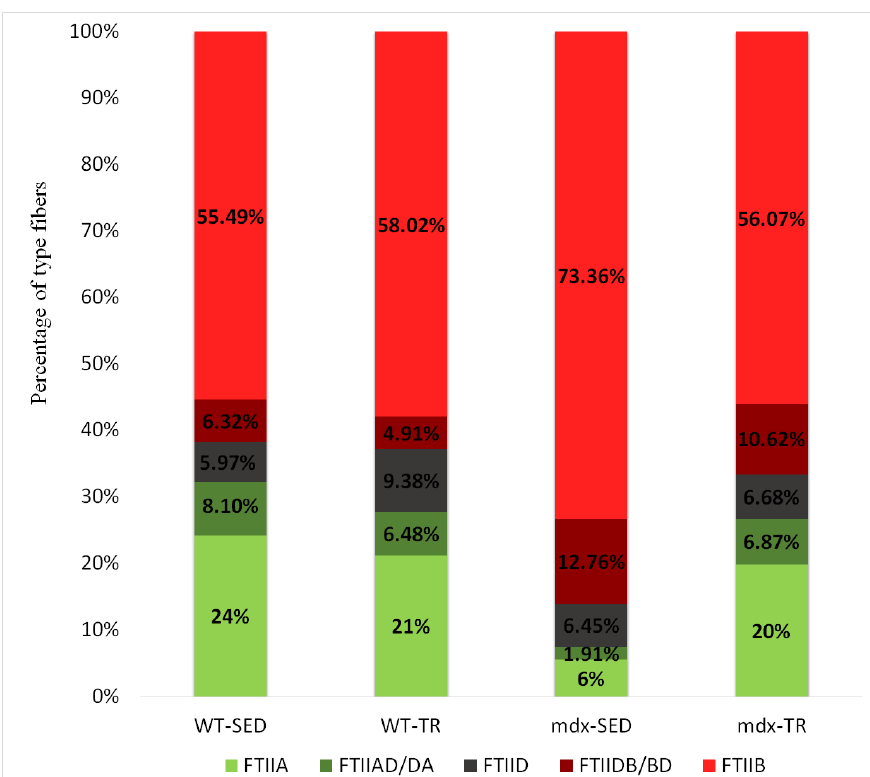
Int. J. Mol. Sci. 2022 , 23 , x FOR PEER REVIEW